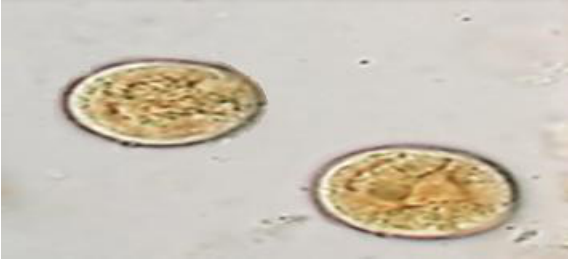
Figure, 2: Trophzoit of B. sulcata in sheep faecal sample stained with Giemsa (100x).